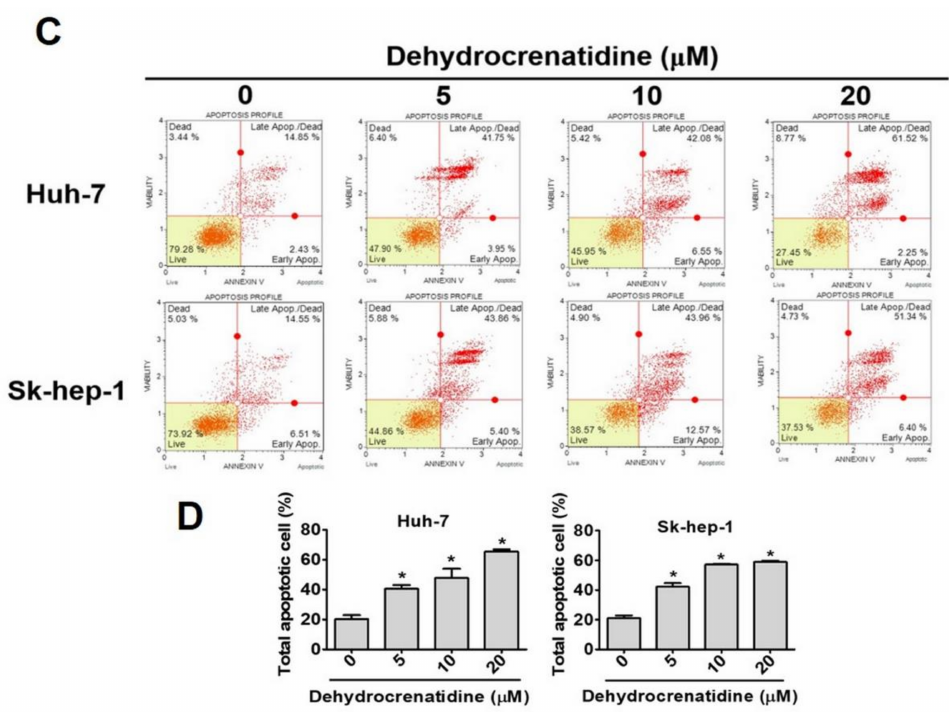
Figure 3. Dehydrocrenatidine induces apoptotic cell death in hepatoma cell lines. ( A ) The Huh-7 and Sk-hep-1 cells were stained with DAPI and observed under a fluorescence microscope. The red arrows show the nuclei condensation area. ( B ) The graphs show quantitative analysis of chromatin condensation of two cells. Bar scale = 100 µ m. ( C , D ) After treated with indicated concentrations (0, 5, 10, and 20 µ M) of dehydrocrenatidine, Huh-7 and Sk-hep-1 cells were stained with annexin-V and PI staining buffer and analyzed through flow cytometry. Student’s t test was applied to determine statistical significance in three experiment. * represented p < 0.05, compared with the control